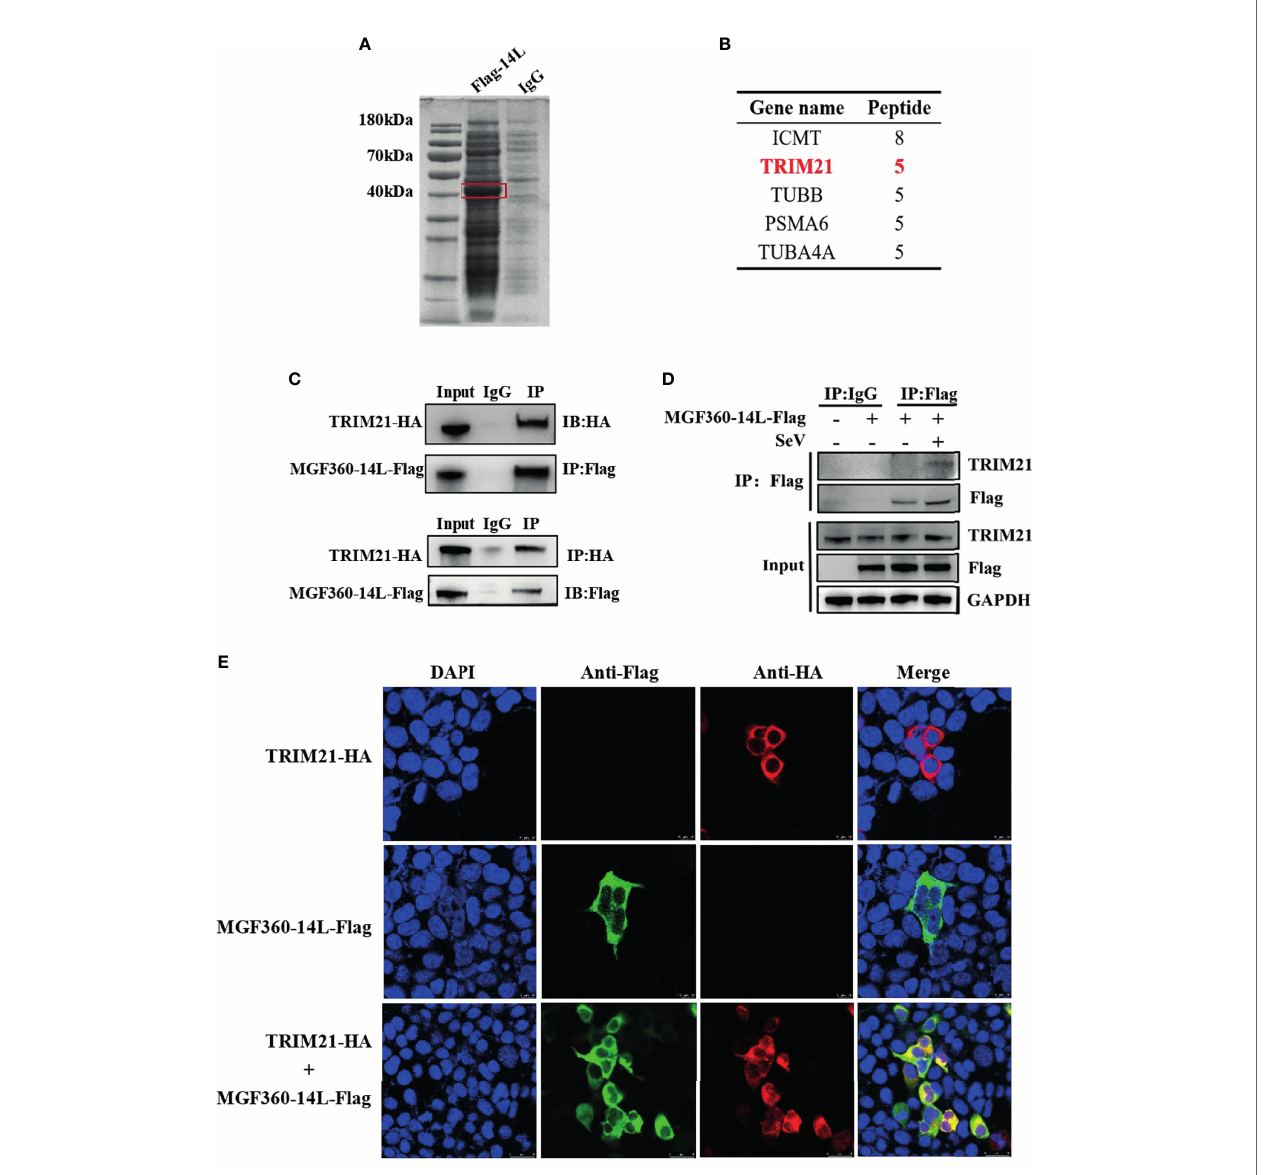
FIGURE 3 | MGF360-14L interacts with TRIM21. (A) IP samples were separated by SDS-PAGE and stained with Coomassie blue; exogenously expressed MGF360-14L is indicated by the red box. (B) MS analysis of MGF360-14L-associated proteins, following by Gene Ontology (GO) analysis. High-scoring peptides were listed in the table. (C) HEK293T cells were transfected with MGF360-14L-Flag and TRIM21-HA plasmids. (D) HEK293T cells were transfected with MGF360- 14L-Flag plasmids for 18 h and then incubated with SeV (1MOI) for 6 h. The cells were lysed and subjected to IP using anti-Flag, anti-HA monoclonal antibodies or control IgG. Precipitates were analyzed by western blot. (E) PK-15 cells were transfected with MGF360-14L-Flag and TRIM21-HA plasmids. At 24 h after transfection, cells were fi xed with 4% paraformaldehyde, permeabilized with 0.1% Triton ™ X-100, blocked with 5% BSA, and then treated with primary antibody and secondary antibody. Finally, laser confocal microscopy was performed after DAPI nuclear